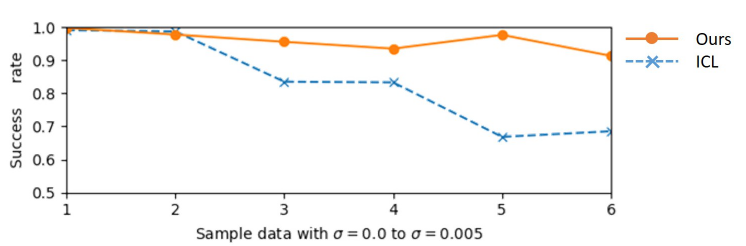
Figure 13. Comparison between the ICL method and our proposed